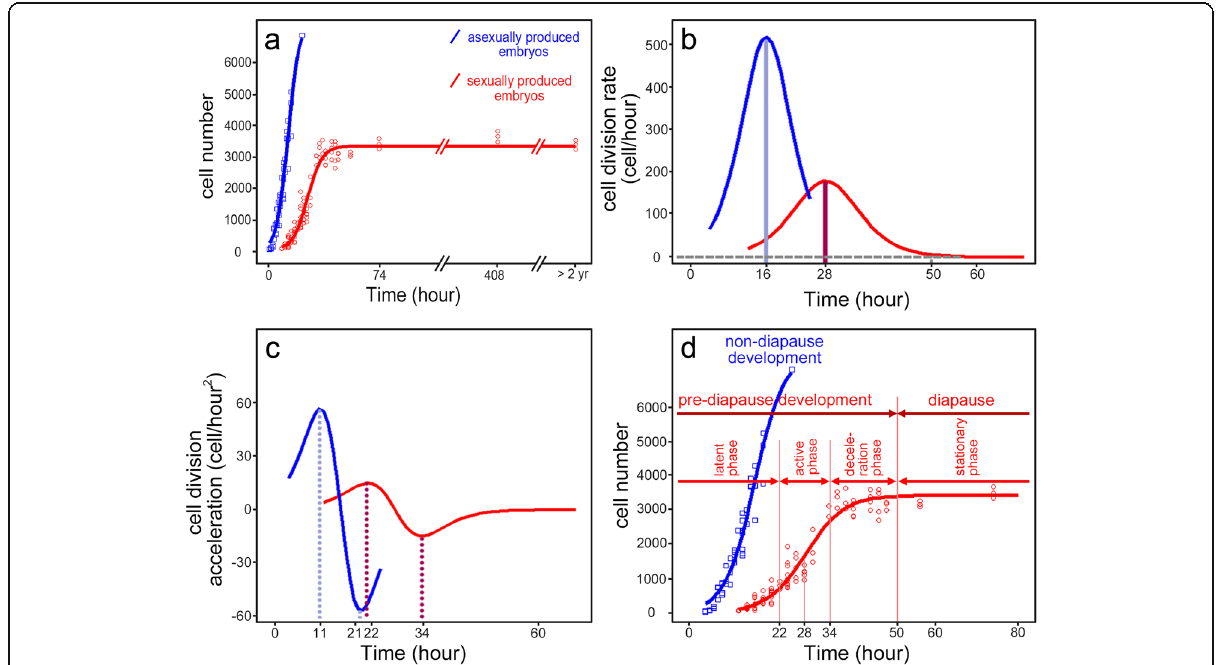
Fig. 1 Cellular growth curves based on DAPI stained nuclei in asexually and sexually produced embryos of Daphnia magna over time post ovulation. a Cell numbers of the asexually produced embryos (blue) increase continuously after ovulation. Cell numbers of sexually-produced embryos (red) are constant at 50 h post ovulation and remain so during the long diapause period (at 4 °C and full darkness). Curves of original data (points) are modelled according to Eq. 1; based on coefficients determined with the logit function in Eqs. 2 and 3. b Lines display modelled cell division rate in both embryo types and was calculated as the first derivative of Eq. 1 with respect to time (see Eq. 4). In asexually produced embryos, cell division rate is highest 16 h post ovulation. In sexually produced embryos, the cell division rate is maximal 28 h post ovulation. c Lines depict cell division acceleration and was calculated as the second derivative of Eq. 1 with respect to time (see Eq. 5) in both embryo types. In asexually produced embryos acceleration of cell division is maximal at 11 h and minimal 21 h post ovulation. In sexually produced embryos, the maximal acceleration of cell division is observed at 22 h and minimal acceleration at 34 h post ovulation. d Descriptive cell growth curves. Based on cell division rate and cell division acceleration embryogenesis can be divided into phases; in asexually produced embryos, there are two phases: i) latent phase: from ovulation to maximum positive acceleration; ii) active phase: the time interval between maximum positive and negative acceleration. These phases are also observed in sexually produced embryos and are then followed by iii) a deceleration phase: the time interval between maximum negative acceleration to the possible cease of cell division (about 50 h post ovulation); iv) stationary phase: